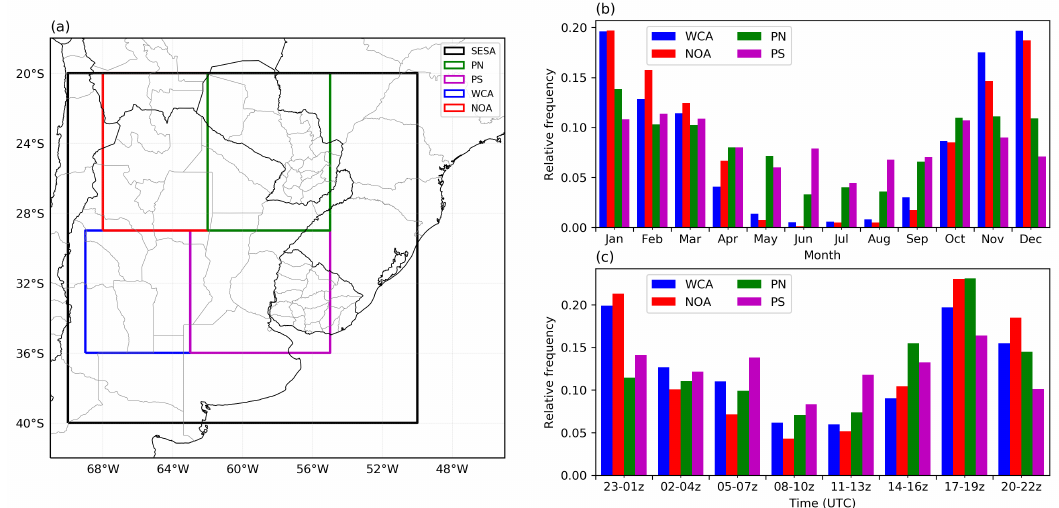
Figure 10. ( a ) SESA and the four selected subregions. ( b ) Annual relative frequency distributions of CI for the subregions. ( c ) Daily relative frequency distributions of convective initiation (CI) for the subregions.